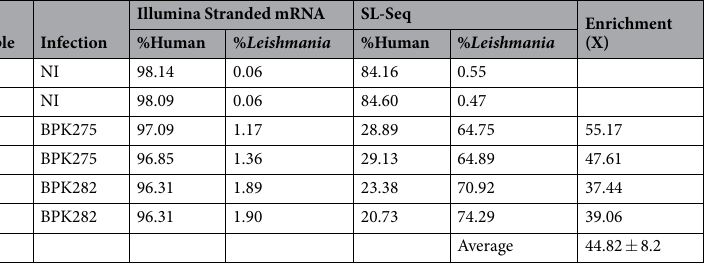
Table 2. Relative enrichment of Leishmania mRNA with SL-sequencing from infected THP-1 monocytes. THP-1 monocytes infected with Leishmania strain BPK275 and BPK282 and uninfected controls were sequenced with both SL-seq and a conventional poly-A mRNA kit (Illumina stranded mRNA). Displayed percentages show the relative amount of sequencing reads mapping to the human (hg38) and Leishmania genome with each kit. The last column indicates how many times SL-seq enriched the Leishmania mRNA compared to the Illumina